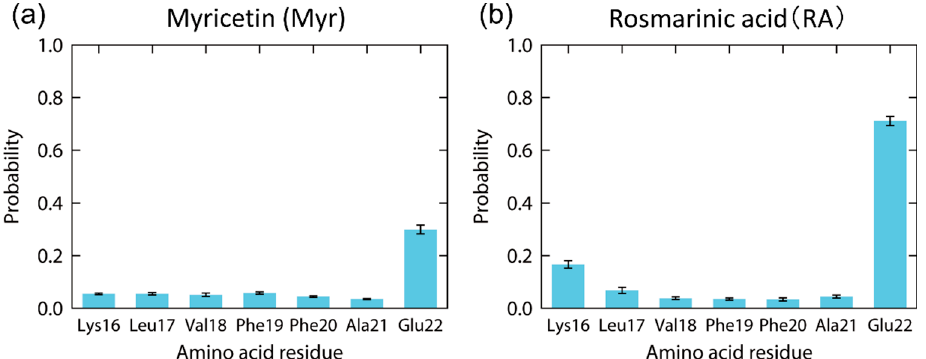
Figure 8. Contact probability of each residue in the A β (16–22) peptide with ( a ) Myr and ( b ) RA at 300 K. Reprinted with permission from Ref. [31]. Copyright 2020 Elsevier.